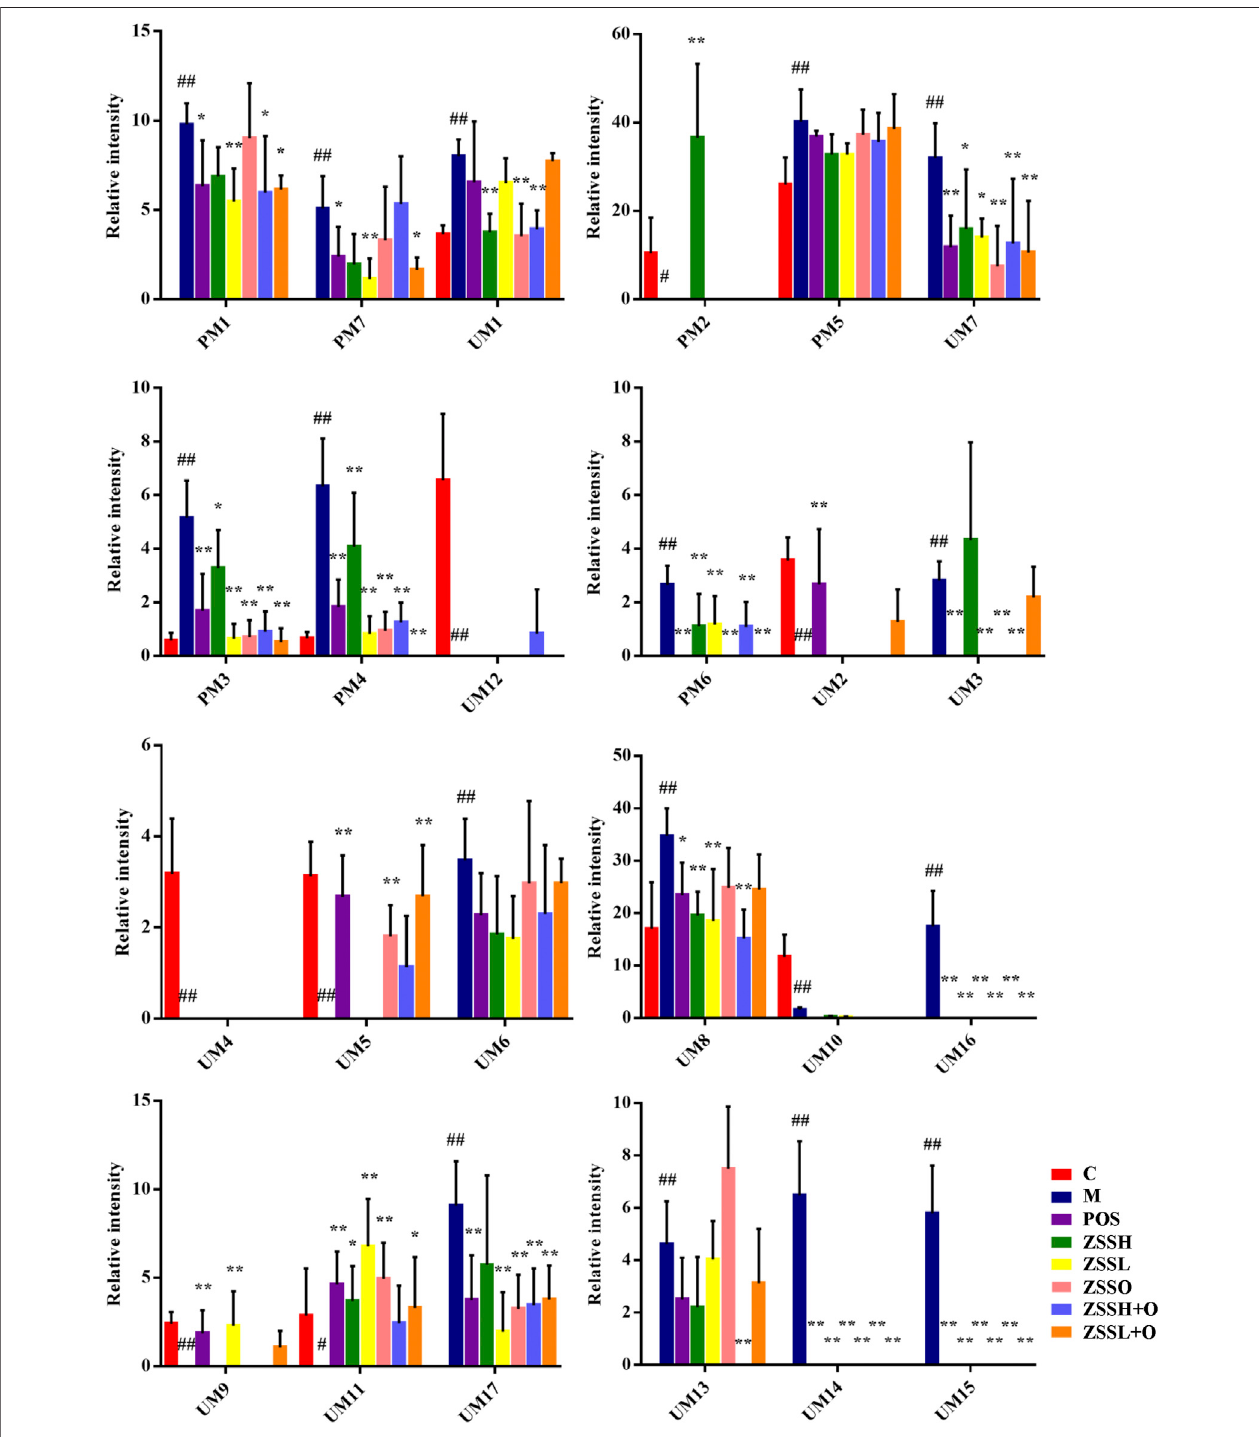
FIGURE4| Relativepeakareasofpotentialbiomarkersidenti fi edinplasmaandurineinpositiveandnegativeionmodes.(C)controlgroup;(M)modelgroup;(POS) positive group; (ZSSH) high-dose ZSS ethanol extract group; (ZSSL) low-dose ZSS ethanol extract group; (ZSSO) ZSS oil extract group; (ZSSH + O) high-dose ZSS ethanol+oilextractgroup;(ZSSL+O)low-doseZSSethanol+oilextractgroup.Valuesarepresentedasthemean ± SD, n (cid:2) 6.# p < 0.05,## p < 0.01:modelvscontrol; * p < 0.05, ** p < 0.01: treatment vs model.